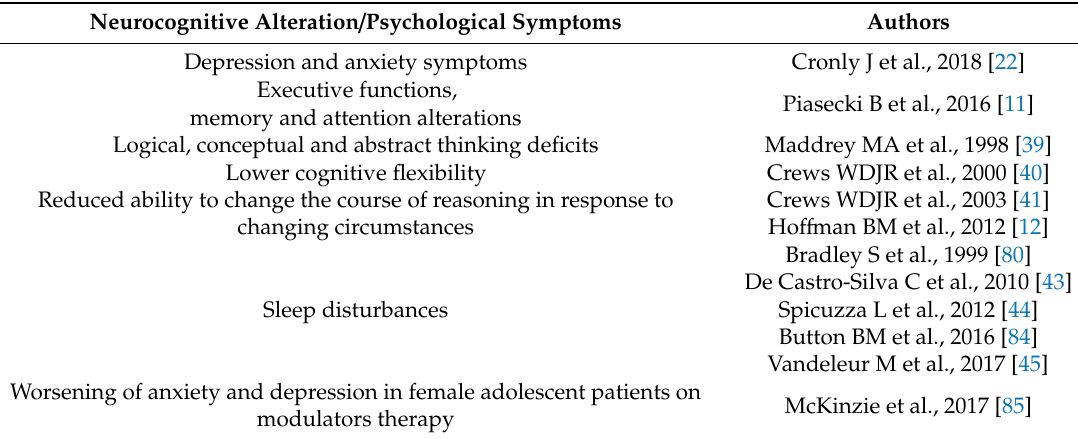
Table 1. Neurocognitive functions’ alterations and psychological diseases in CF